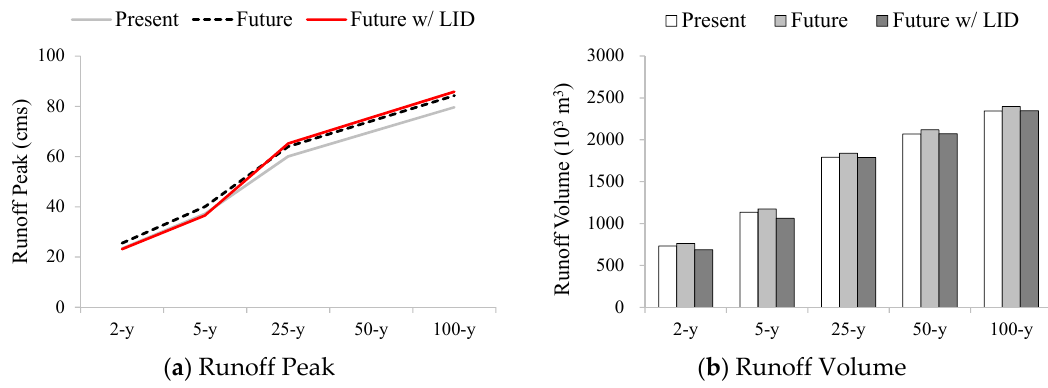
Figure 9. ( a ) Runoff peak and ( b ) runoff volume for different return periods under land-use scenarios of present, future, and future with LID.